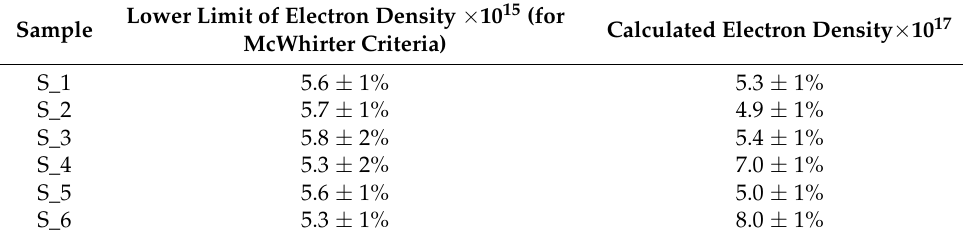
Table 5. Table for the lower limit and the calculated value of electron density.